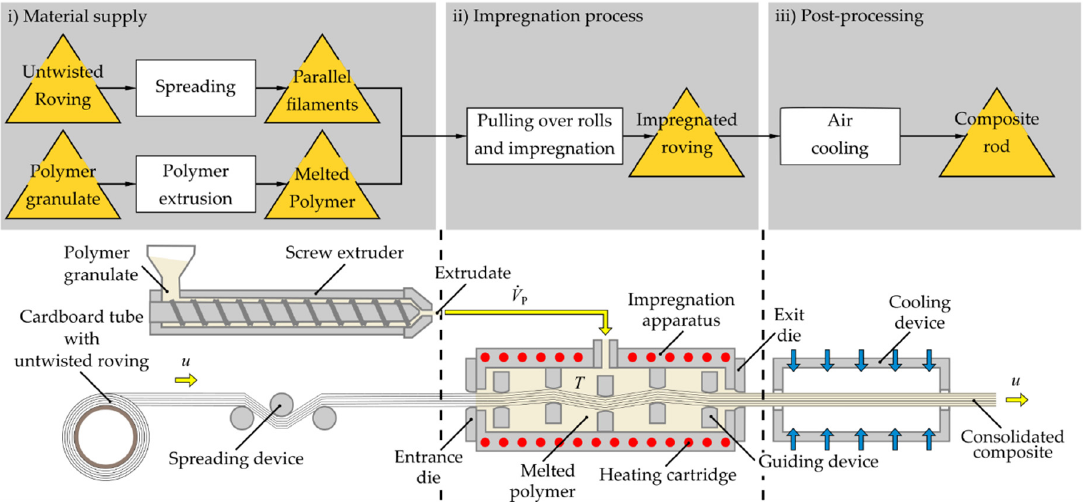
Figure 4. Process chain of thermoplastic pultrusion: process diagram ( top ) and schematic of manufacturing steps ( bottom ).